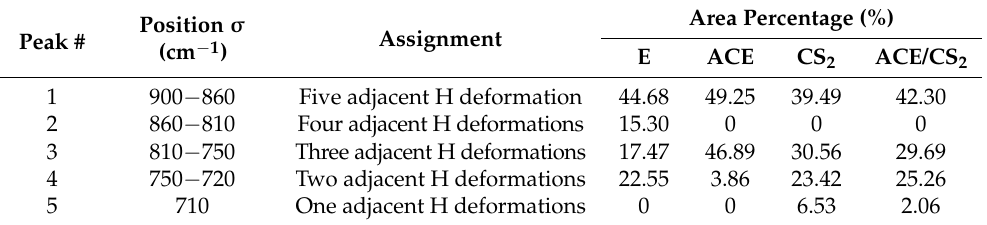
Figure 7. Infrared spectra of the original and extractive residues in the 700–900 cm − 1 region. (( a ) is an original tar residue fit, ( b ) is a fit to carbon disulphide, ( c ) is a fit to acetone and ( d ) is a fit to a mixed solvent. The red line is the fit line and the blue line is the sub peak). Table 7. Infrared spectra of four samples 700–900 cm − 1 split peak fi tt ing ratio of each absorption peak area.